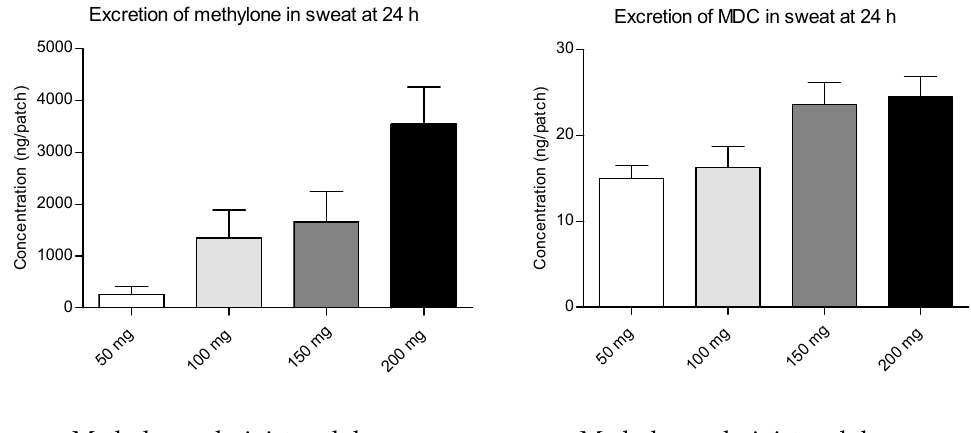
Figure 3. The 24 h excretion of methylone and MDC in sweat following increased controlled methylone administrations (50, 100, 150 and 200 mg).